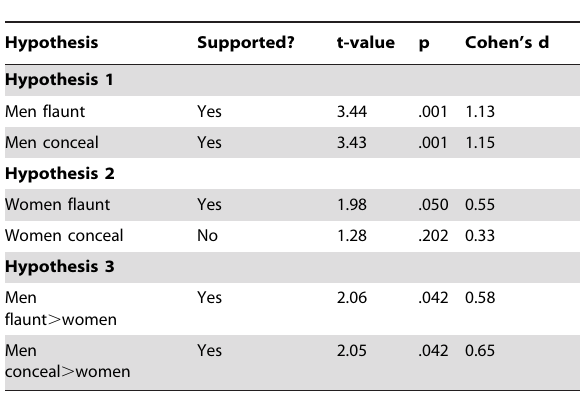
Table 1. Summary Results for Flaunting and Concealing